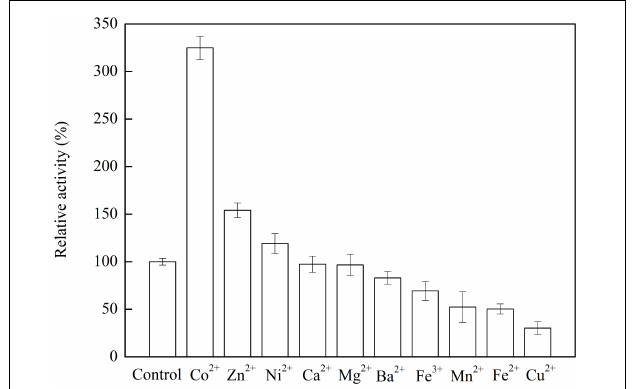
FIGURE 6 | Effects of metal ions on the ADH activity. The conditions for obtaining the highest enzyme activity were set to 100%.